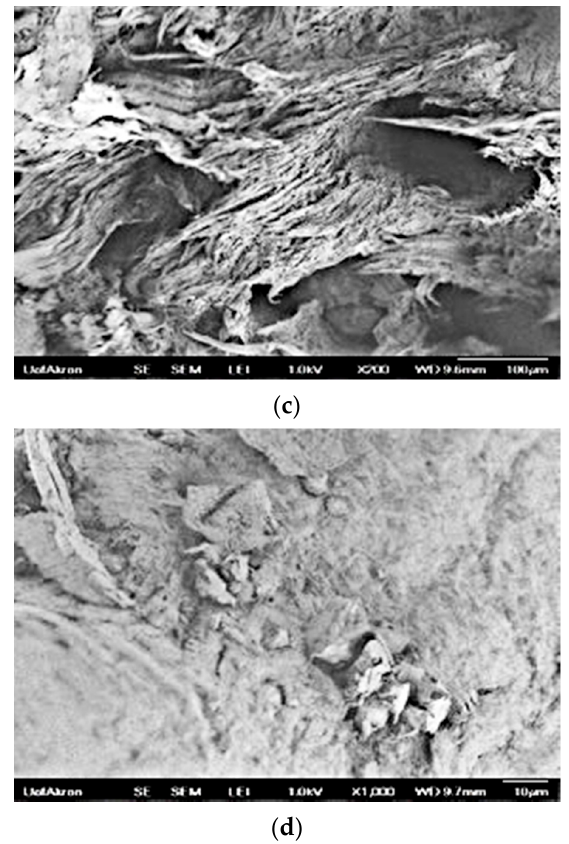
Figure 13. SEM images of the fracture surface for LLDPE composite samples with: ( a ) 50 wt.% PSBH-A (X200); ( b ) 50 wt.% PSBH-A (X1000); ( c ) 20 wt.% GSBH-A (X200); and ( d ) 20 wt.% GSBH-A (X1000).